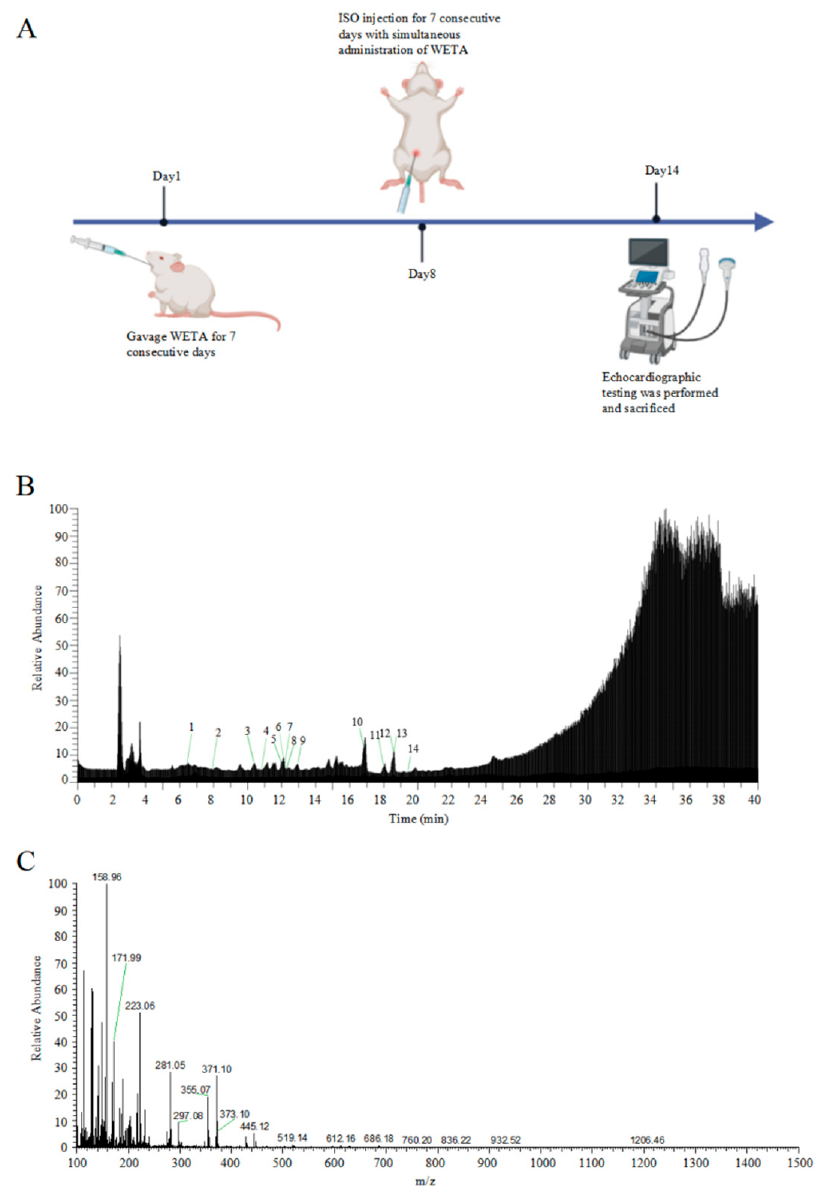
Figure 1. Identification of WETA compounds using LC-MS. ( A ) The experimental design flow, ( B ) total ion chromatogram of WETA, ( C ) MS 2 spectrum of WETA. 1, Salsolinol; 2, Karakoline; 3, Isotalatizidine; 4, Napelline; 5, Neoline/Bullatine B; 6, Neoline; 7, Lycoctonine; 8, Fuziline (15- α - Hydroxyneoline); 9, Talatisamine; 10, Benzoylmesaconine; 11, Benzoylaconine; 12, Hypaconitine; 13, Benzoylhypaconine; 14, Aconitine. Table 1. The identification of bioactive compounds in WETA by full MS/dd-MS 2 [22].